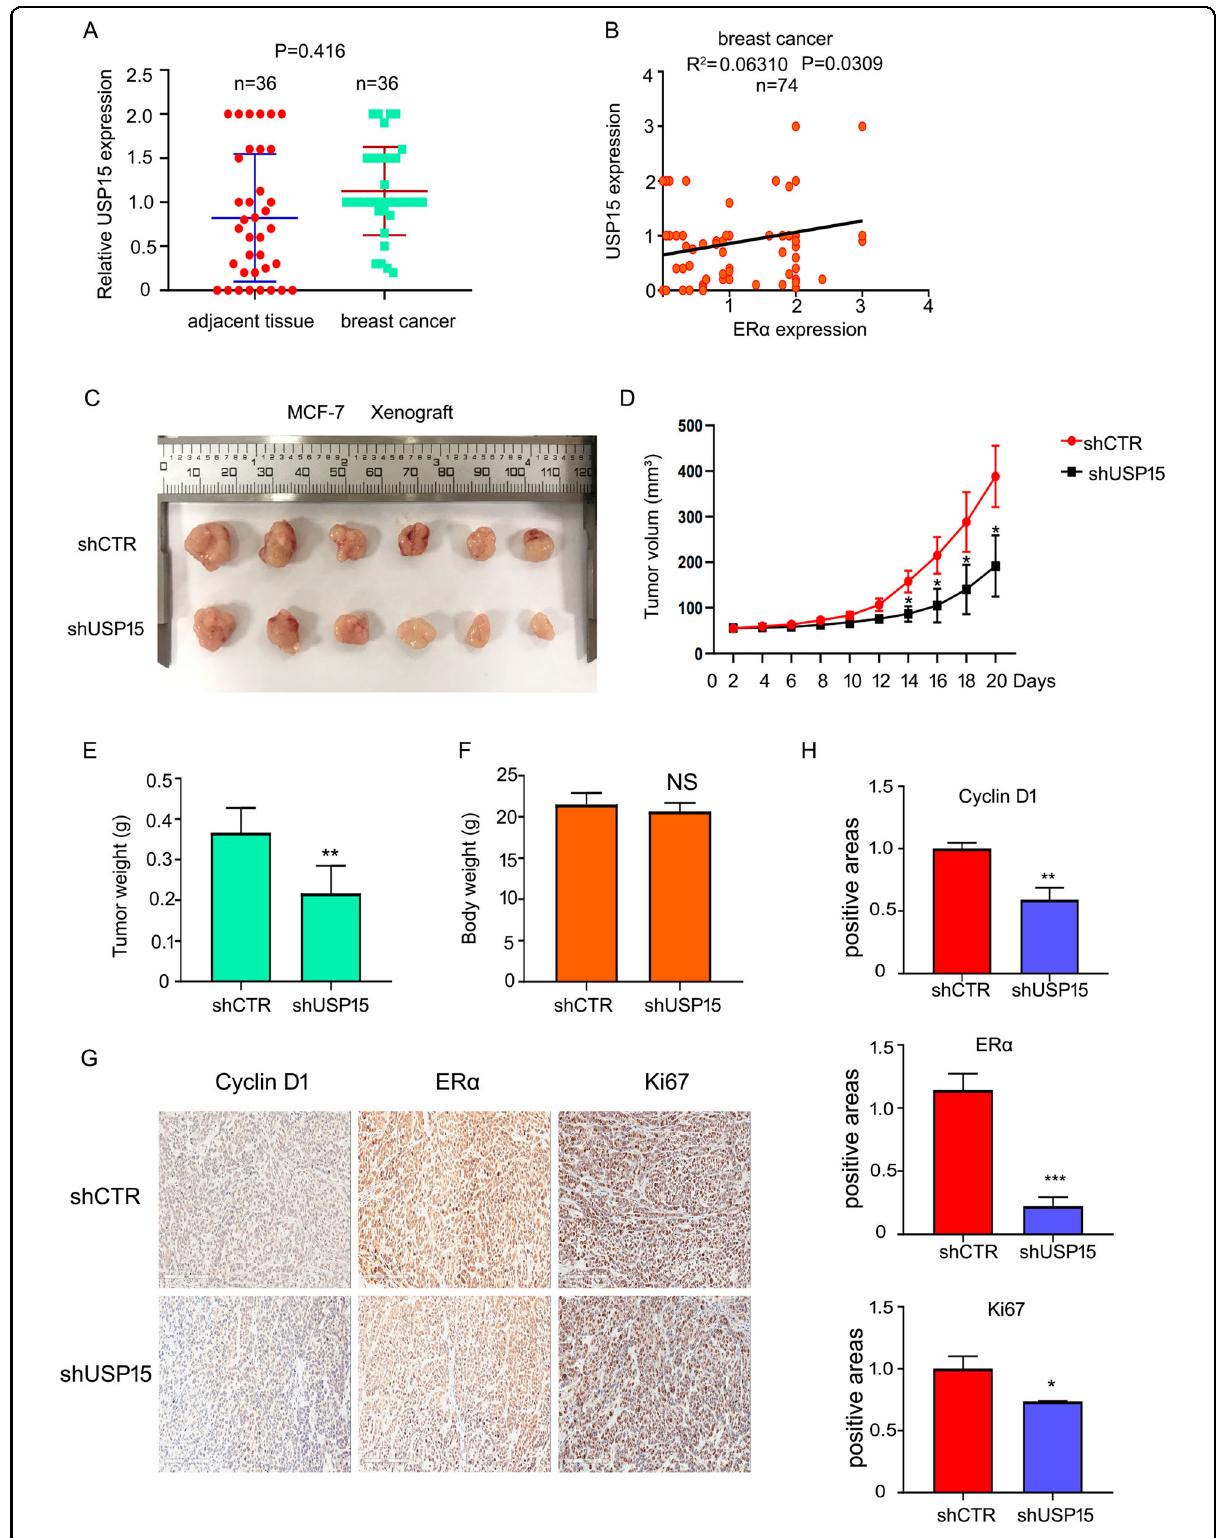
Fig. 7 USP15 silence inhibits cancer progression in MCF-7 xenograft. A Expression of USP15 in human breast cancer tissues ( n = 36) and adjacent tissues ( n = 36). B The correlation of USP15 and ER α levels ( n = 74). C Tumor images of mice with injected of MCF-7 cells stably expressing USP15 shRNA. D Tumor volume, E tumor weight and F body weight were showed. * p < 0.05, ** p < 0.01 versus each vehicle control. G , H ER α , Ki67, Cyclin D1 expression were tested using immunohistochemical assay. * p < 0.05, *** p < 0.001 versus each vehicle